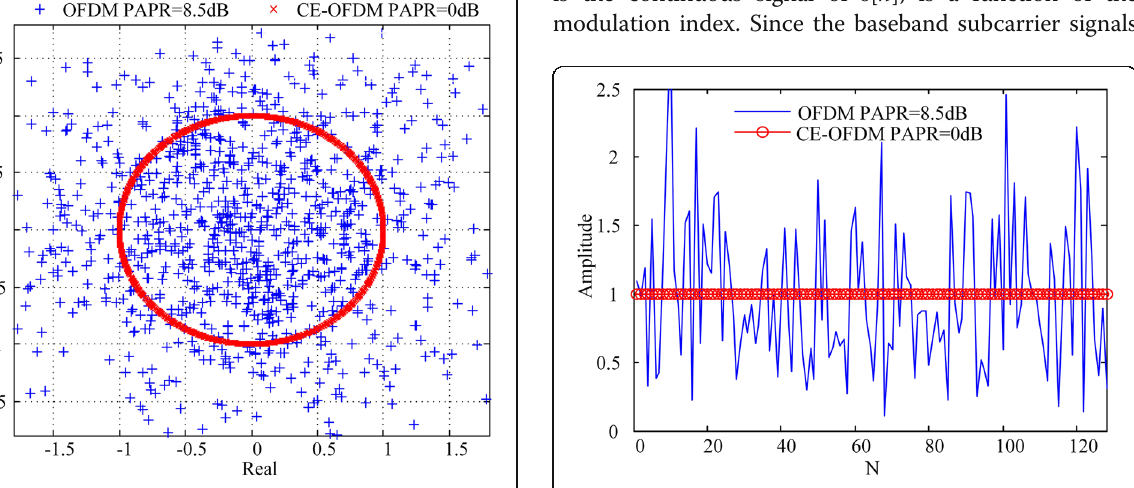
Fig. 4 Amplitude diagram of random signals of OFDM and CE-OFDM. Detailed legend: the line represents the OFDM signals with 8.5 dB PAPR and the line with a circle represents the CE-OFDM